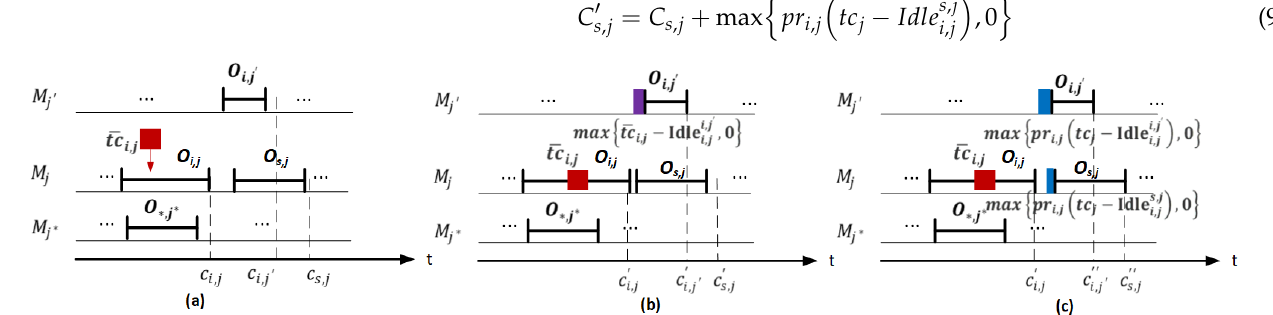
Figure 4. The influence of RMBs on the single operation and its subsequent operation time arrange- ment. ( a ) Operation 𝑂 𝑖,𝑗 increases expected repair time. ( b ) The effect of the start time of 𝑂 𝑖,𝑗 ′ . ( c ) The effect of the start time of 𝑂 𝑠,𝑗 .